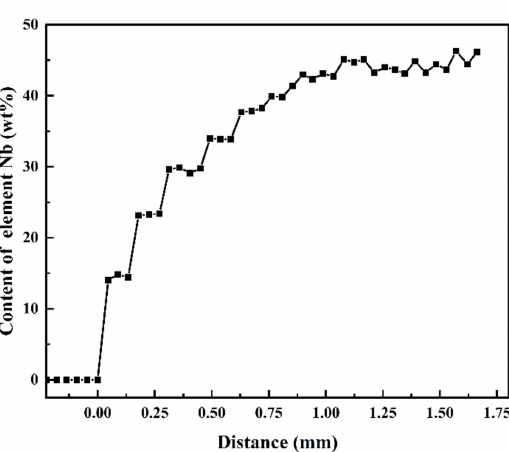
Figure 6. The Nb content vs. the distance from the molten line of the 10-layer sample.